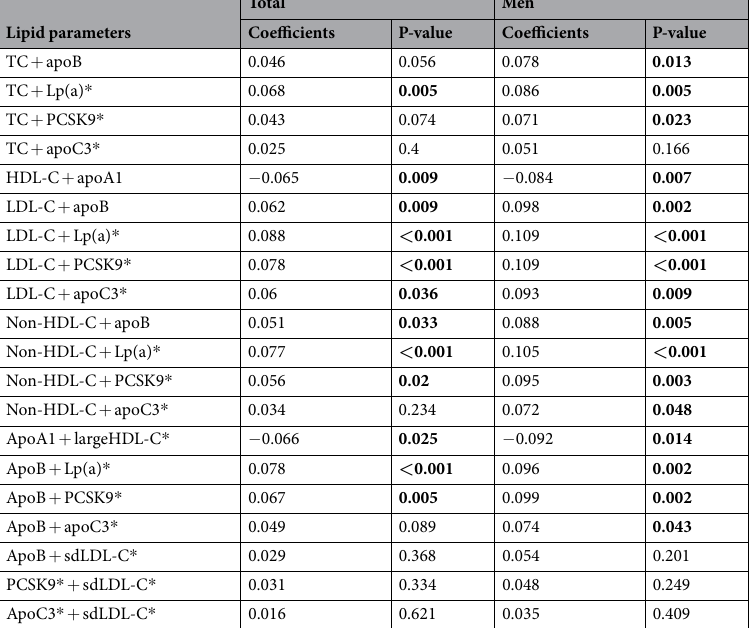
Table 4. The interactions between lipid biomarkers on coronary severity using linear regression analysis. Multiple linear regression analyses were performed and standard coefficients were showed with adjustment for age, gender, hypertension, HbA1c, current smoking and hs-CRP. The interaction terms between the lipid biomarkers in the couples were calculated as the product terms (multiplied the levels of prior lipid by the levels of posterior). The bold values indicate statistical significance and were bolded to improve the readability of the table. * Log-transformed data. Abbreviations as Table